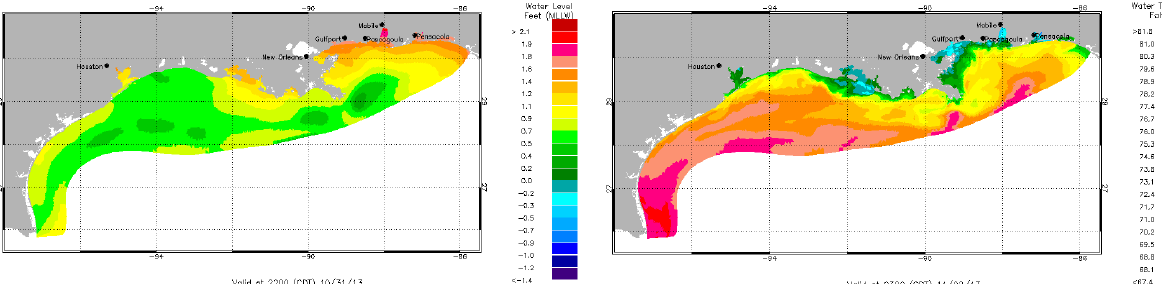
Figure 16. Surface elevation and temperature contours from NGOFS forecast